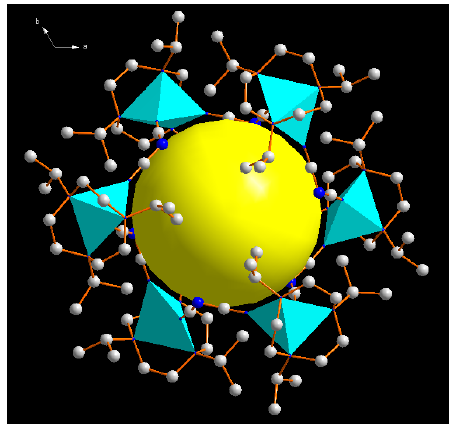
Figure 3. Molecular structure of the cyclic hexanuclear cation of 1 showing the cavity.